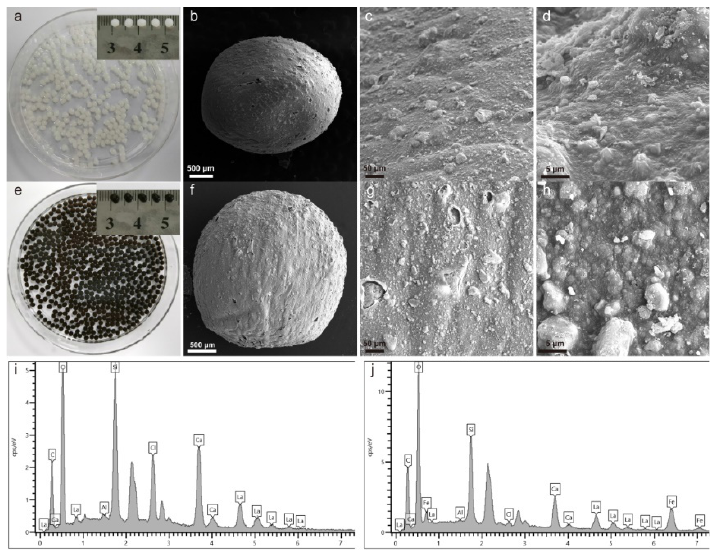
Figure 2. Optical and SEM images of ( a – d ) ALS-B; ( e – h ) MALS-B; EDS of ( i ) ALS-B and ( j ) MALS-B.